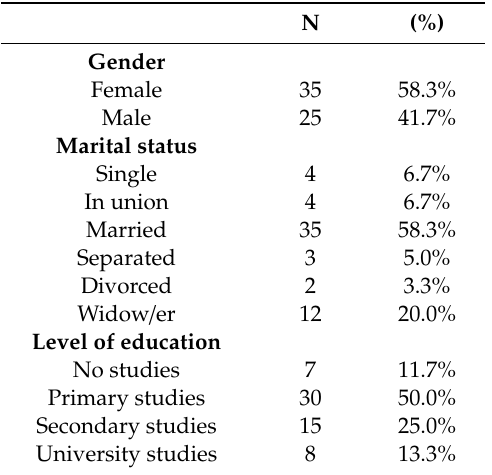
Table 1. Features of studied